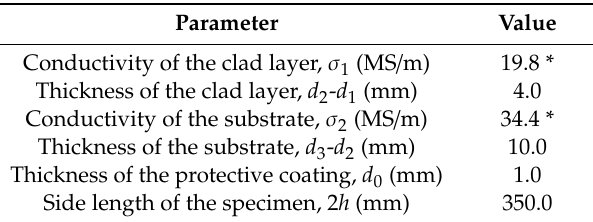
Table 2. Parameters of the specimen.